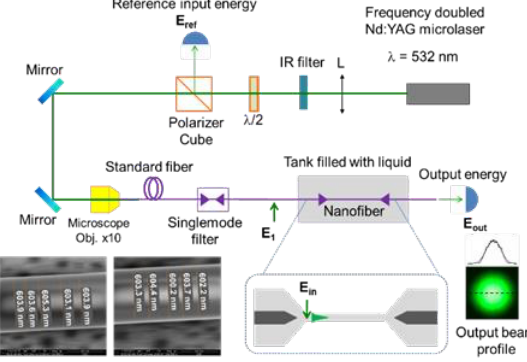
Fig. 1 . Experimental setup. Bottom right: far-field picture of the output mode with cross section and Gaussian